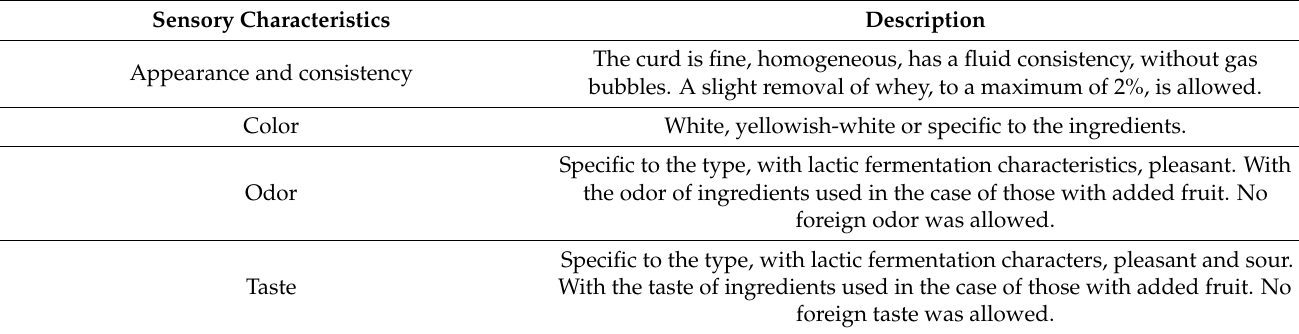
Table 1. Sensory characteristics of the